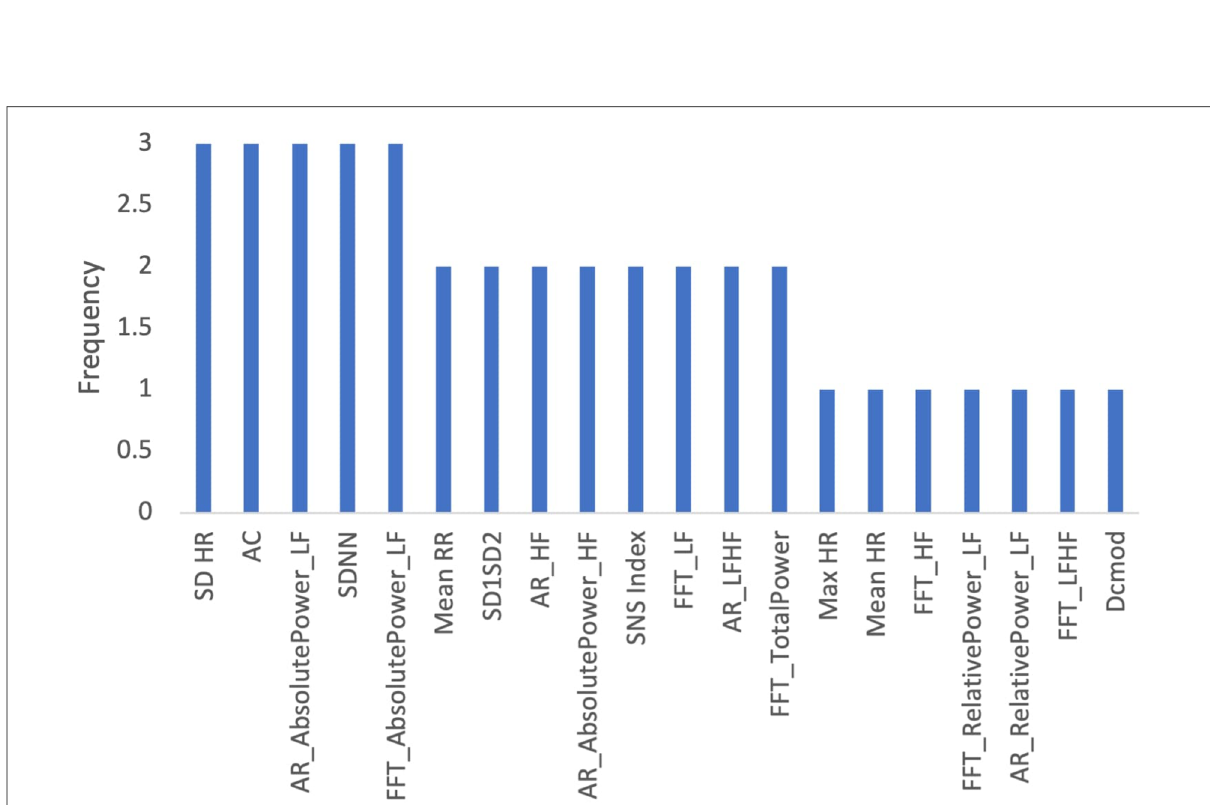
FIGURE 9 Frequency of features in age related